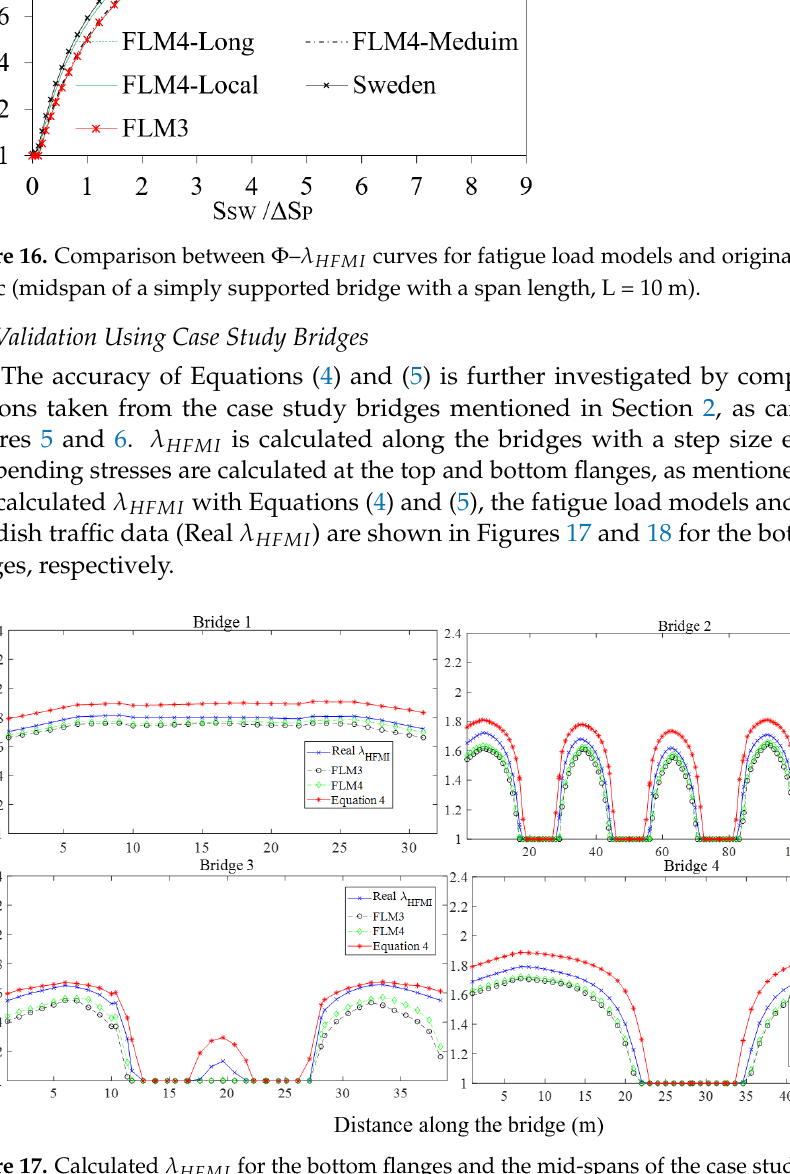
Figure 17. Calculated λ HFMI for the bottom flanges and the mid-spans of the case study bridges (the real λ HFMI was calculated using the original Swedish data